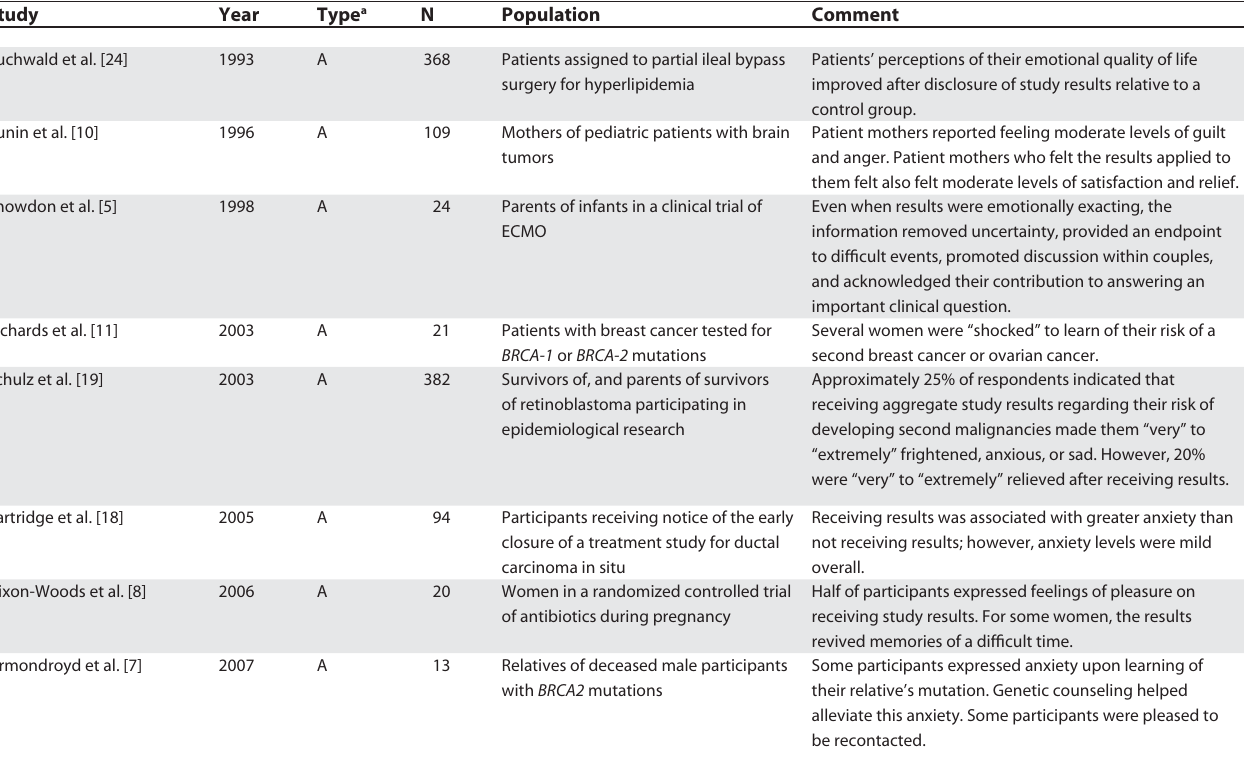
Table 4. Impact on Participants of Receiving Research Results